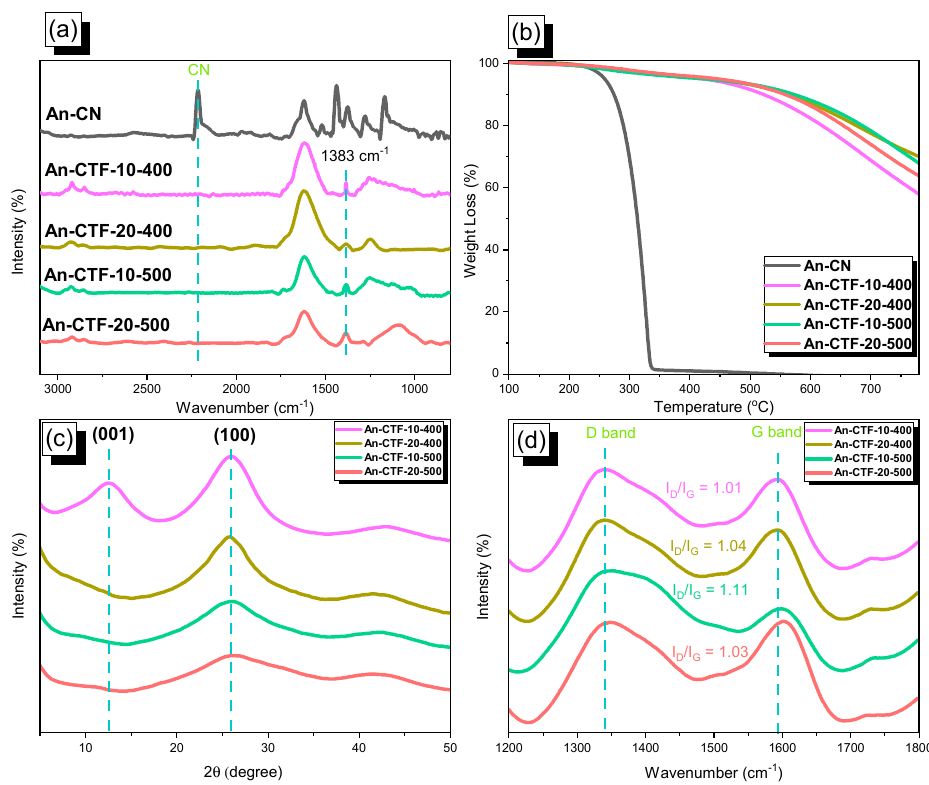
Figure 2. FTIR ( a ), TGA ( b ), XRD ( c ), and Raman ( d ) analyses of An-CN, An-CTF-10-400, An-CTF-20-400, An-CTF-10-500, and An-CTF-20-500. Table 1. TGA, porosity, and CO 2 uptake of An-CTFs.